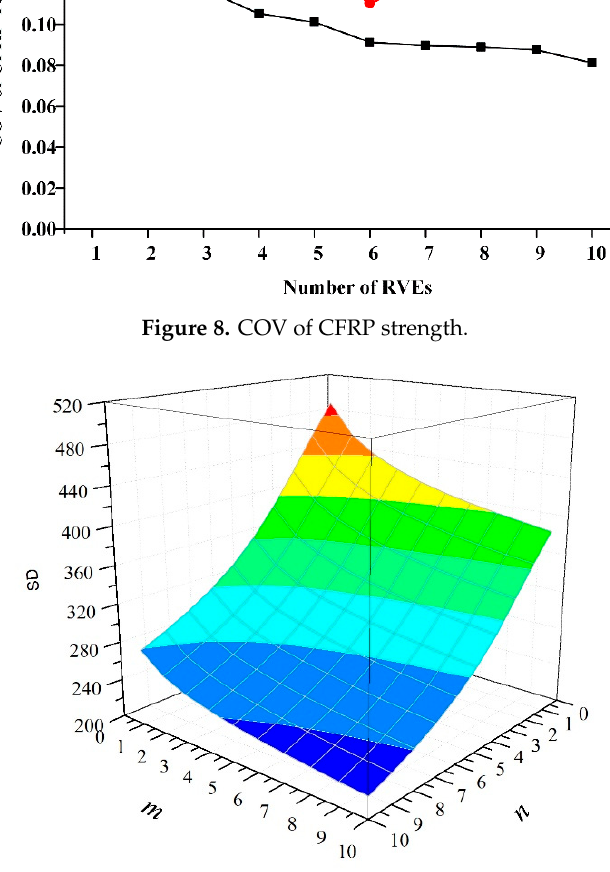
Figure 9. Relationship between standard deviation of strength and system size.